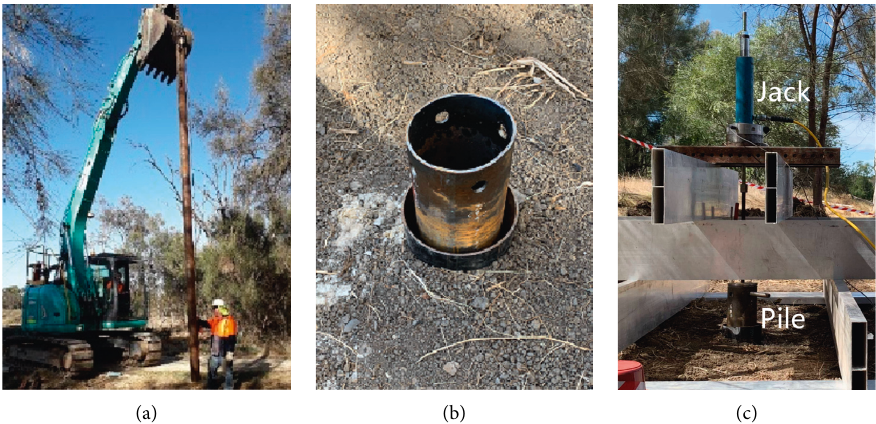
Figure 4: Photos of pile installation and load test: (a) pile installation, (b) installed pile, and (c) pile field